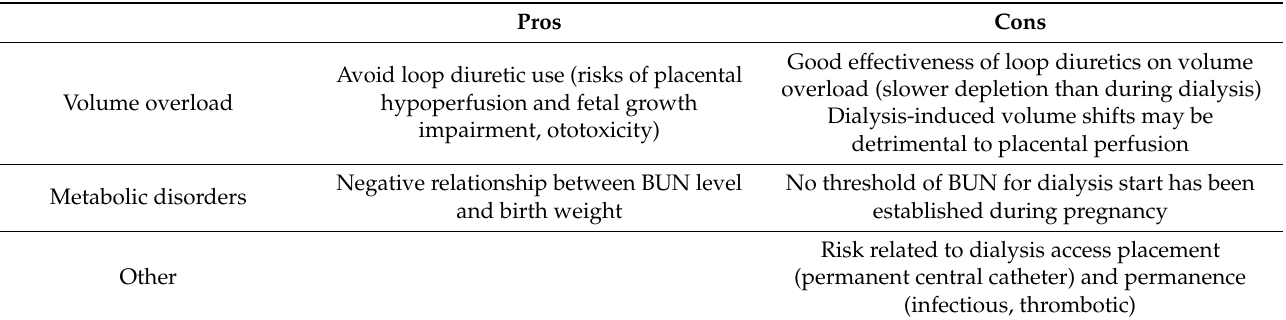
Table 1. Pros and cons of early dialysis initiation in pregnancy. Pros